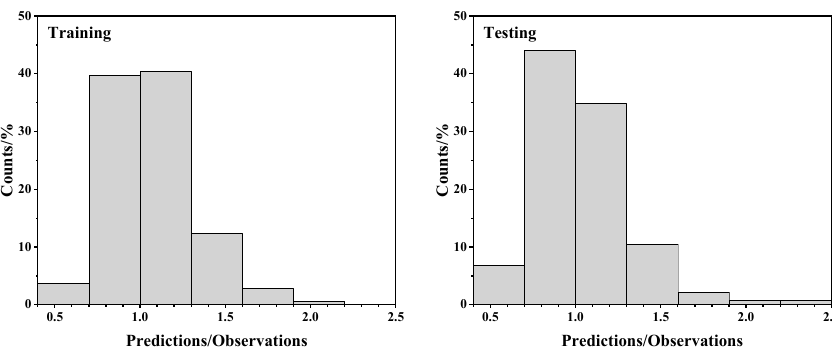
Figure 10. Histogram of the ratio of XGBoost for predicted and observed PGA.